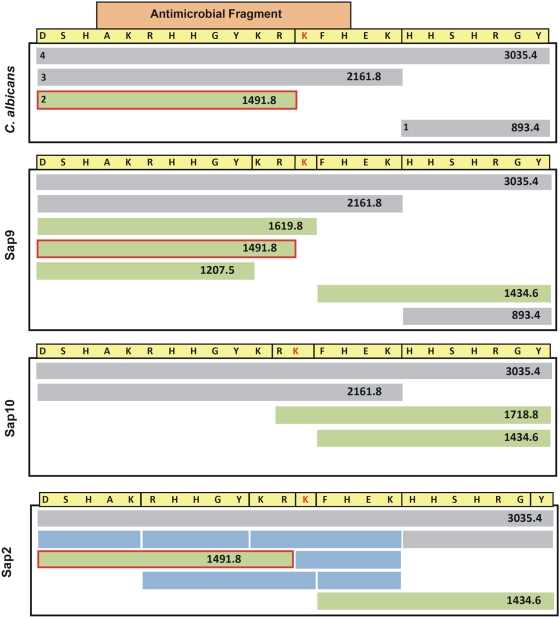
Comparison of cleavage fragments (1–4) identified by Mass Spectrometry following degradation of Hst-5 with C. albicans whole cells and purified Sap9, Sap10 or Sap2 proteases.The boxed fragment in orange represents the part of the peptide with antimicrobial properties. The green bars represent the fragments generated from cleavage within the antimicrobial fragment. The green bars boxed in red are the 1491.8 Da fragments generated by cleavage before Lys13 by C. albicans cells and Sap9. The blue bars represent the fragments generated only by Sap2 protease.